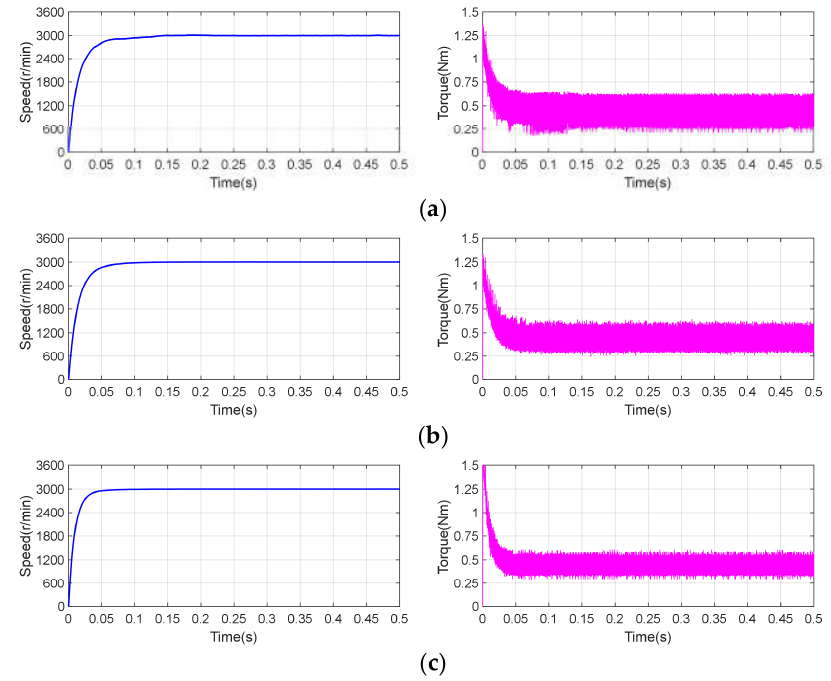
Figure 8. Experimental results under 0.3 Nm. ( a ) PI, ( b ) SMC, and ( c ) proposed TSMC.